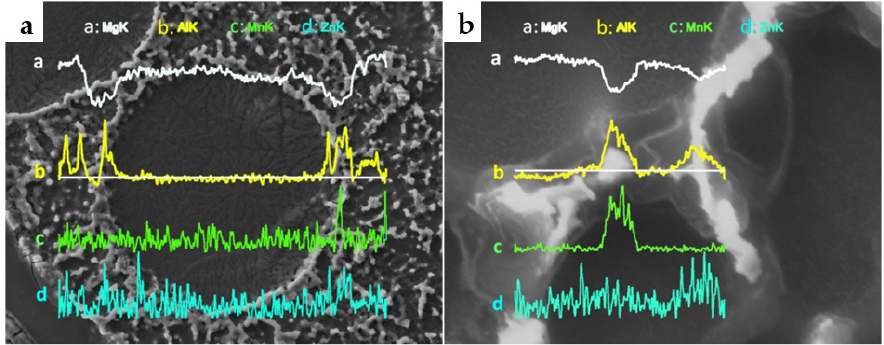
Figure 11. EDS line scan analyses of compositional variation across primary α -Mg ( a ) and eutectics ( b ).